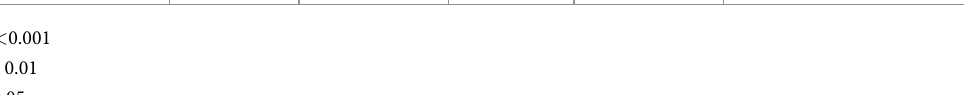
Table 5. The homeostatic regulation coefficient (H) and parameters calculated from the linear regression for leaf ecological stoichiometry (N:P) of three alien plants with stolon and their congenerics. Species Rate 1/ H R 2 H Stoichiometric homeostasis Relative growth rate W . trilobata N:P 0.36 ��� 0.83 2.78 ��� Weak homeostasis 0.065 ± 0.008 ��� 0.67 6.25 �� homeostasis 0.077 ± 0.007 ��� absolute